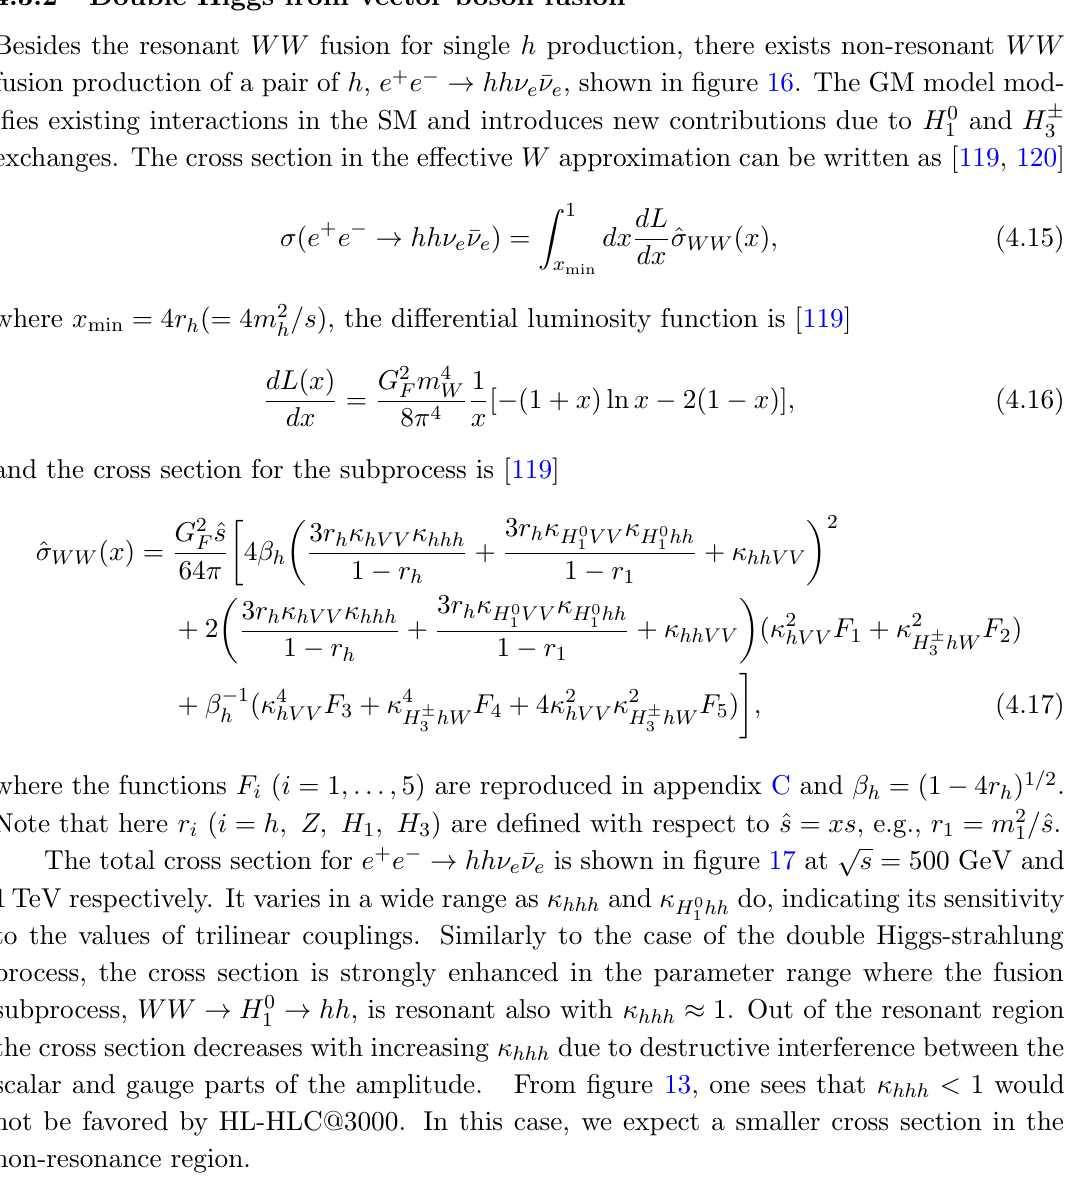
Figure 16 . Feynman diagrams for double Higgs production from WW fusion at e + e (cid:20) hhh , leading to enhanced cross section with (cid:20) hhh > 1 or suppressed cross section